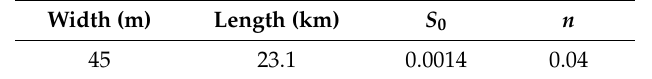
Table 6. The geometrical characteristics of the river reach in the Tiber river, Central Italy.